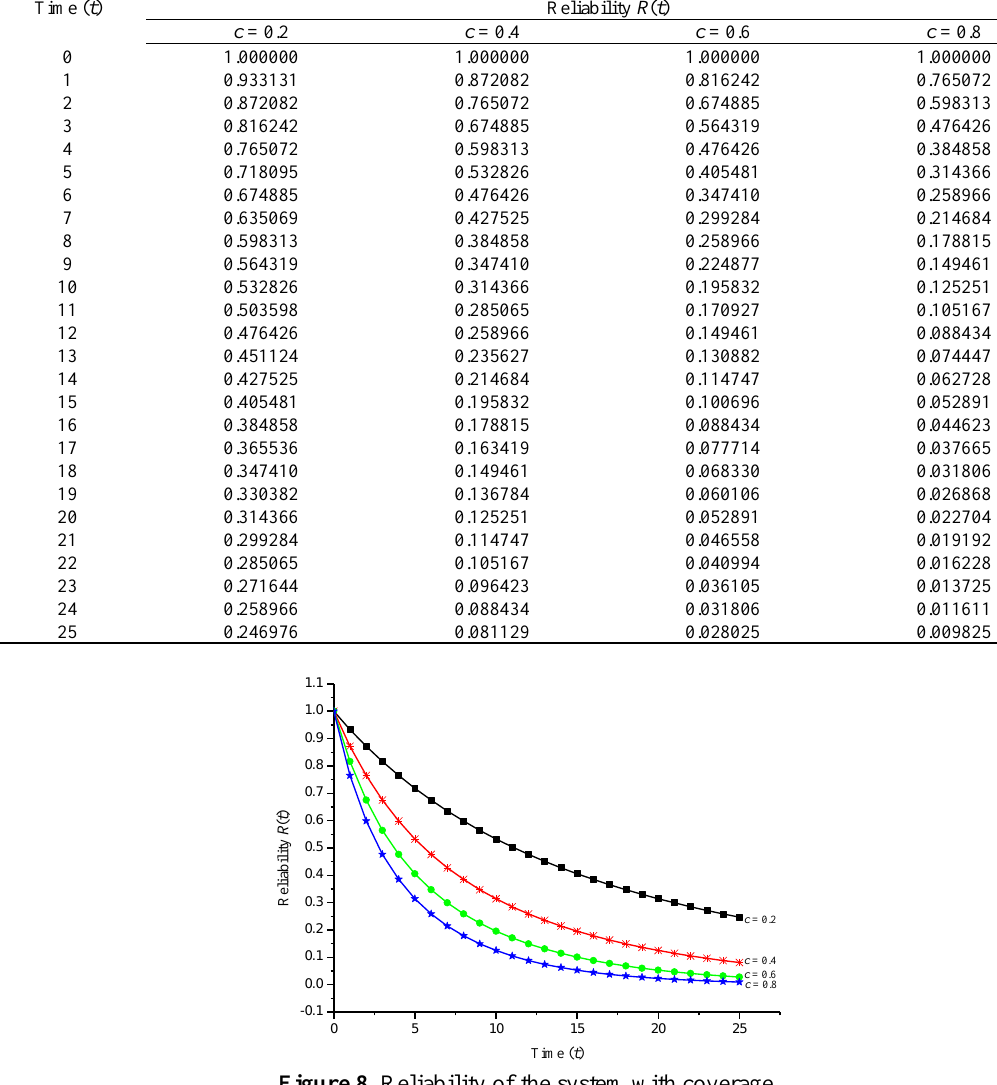
Table 8. Reliability of the system with coverage.